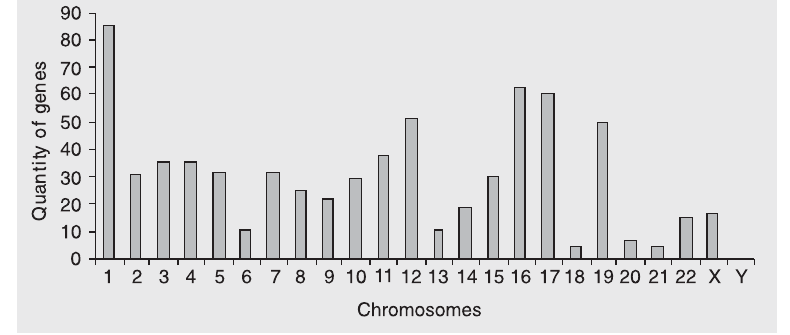
Figure 3. Number of the genes in the human